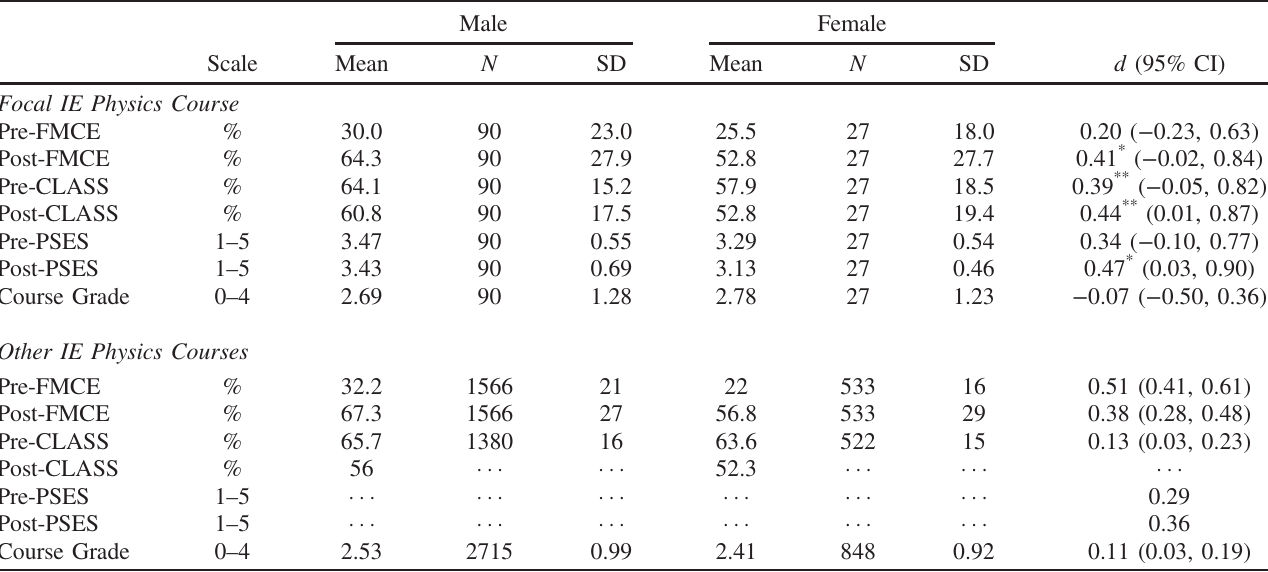
TABLE V. Gender differences in trait measures for the focal IE physics course and the courses studied by Kost et al.